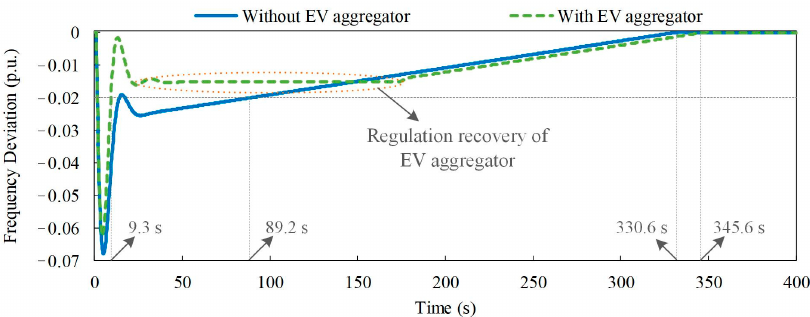
Figure 7. System frequency regulation without and with the EV aggregator.